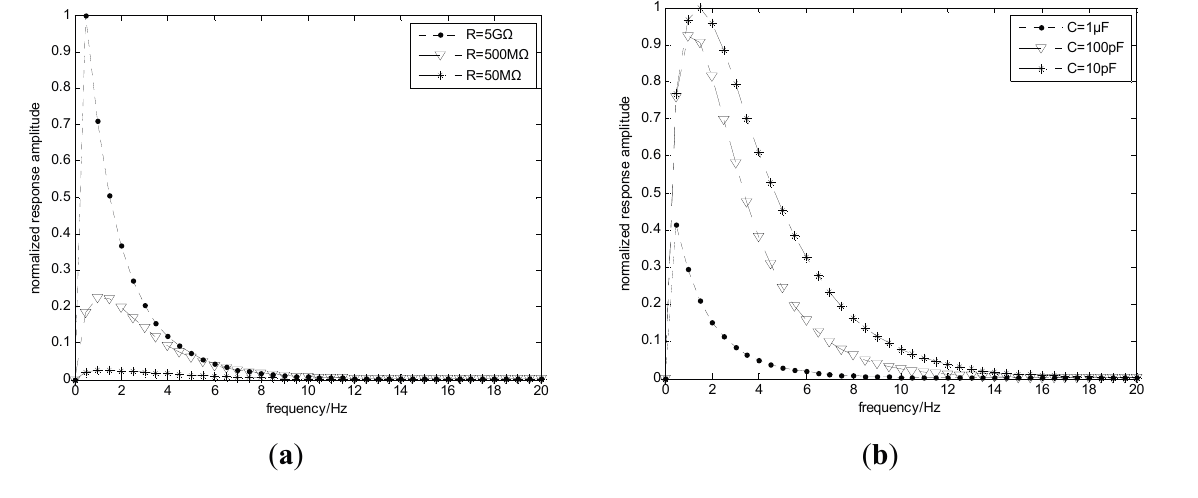
Figure 11. System frequency responses for different resistances ( a ) and capacitances ( b